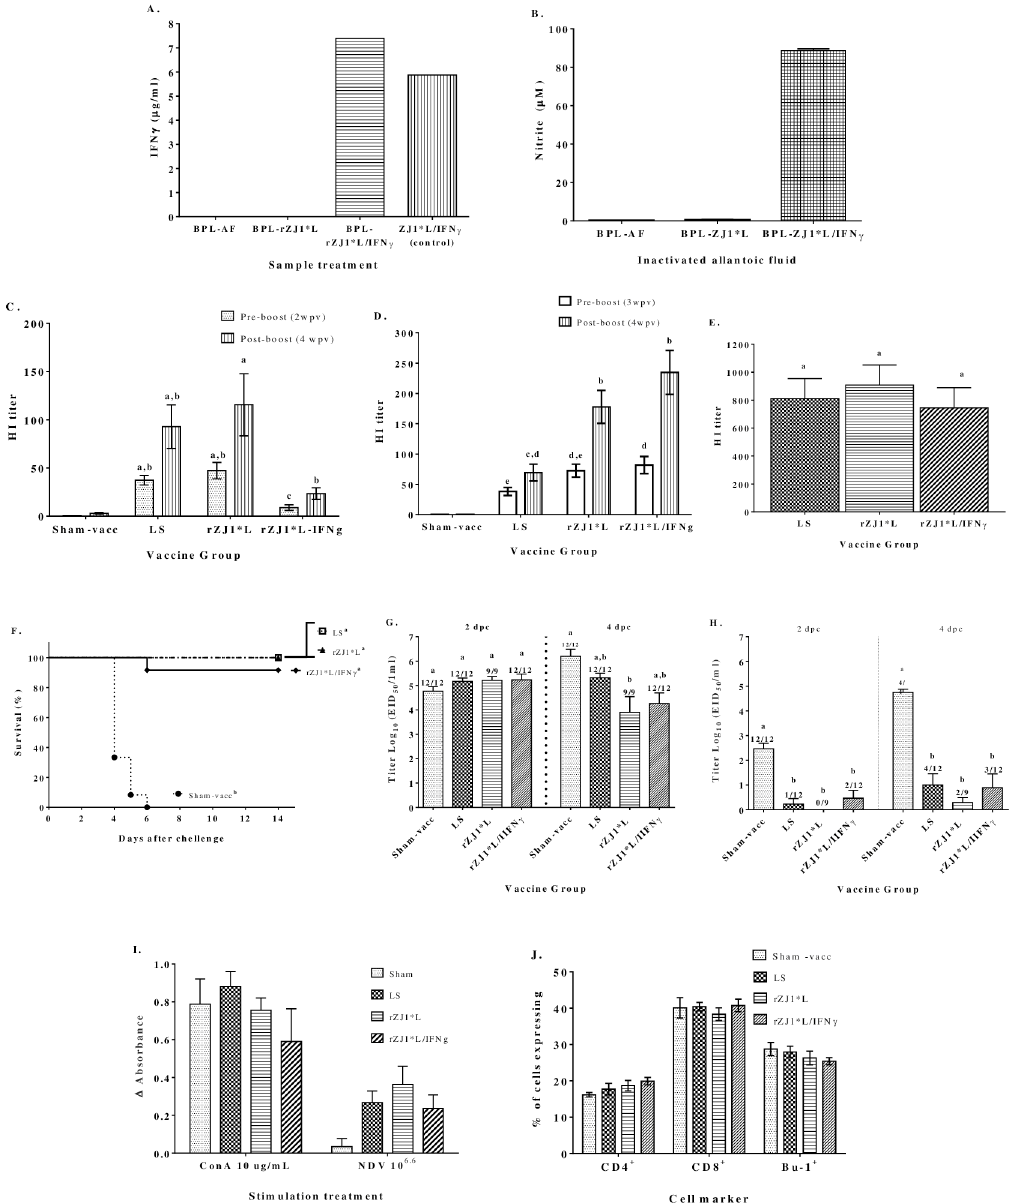
Fig 3. Characterization and evaluation of the effect of co-delivering chIFN γ with an inactivated recombinant vaccination system. Uninfected allantoic fluid (AF), rZJ1 * L- and rZJ1 * L/IFN γ -infected AFs were inactivated with BPL for inactivated vaccine preparation and tested for chIFN γ concentration by ELISA (A) . BPL-treated AFs were used to stimulate HD11 cells and confirm chIFN γ bio-activity through determination of nitrites as a sub-product of nitric oxide induced upon macrophage activation. Stimulated cells were incubated for 48 hrs at 37°C under a 5% CO 2 atmosphere. Cell culture was used to determine nitrite concentration using the Griess method (B) . Two-week- old SPF birds were vaccinated and boosted with inactivated Sham-vaccine, rZJ1 * L or rZJ1 * L/IFN γ . Two different vaccine doses were tested and serum samples were collected before and after challenge for antibody titer determination by HI test. Pre-challenge HI titers after vaccination with an EID 50 /mL of 10 8.1 (C) and 10 9.1 (D) , and post-challenge titers (E) are shown. Mortality was recorded daily for 2 weeks (F) . Oropharyngeal (G) and cloacal (H) swab samples were collected 2 and 4 dpc, viral titers were determined in 10-day-old ECEs and are expressed as EID 50 /mL. One week after booster vaccination, 6 birds from each vaccinated group were euthanized and the spleens were collected for the isolation of lymphocytes to be used in a proliferation assay to measure antigen-specific memory T cell response (I) and to determine T and B cell subpopulation by flow cytometric analysis (J) . Hemagglutination inhibition (HI) antibody titers, viral shedding and cell proliferation assay results were analyzed